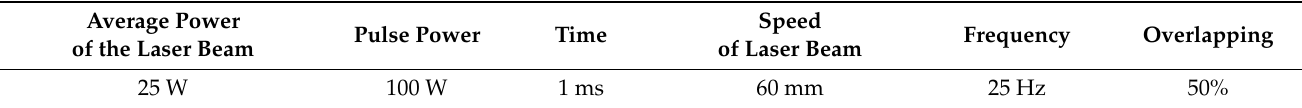
Table 3. The parameters of laser treatment.